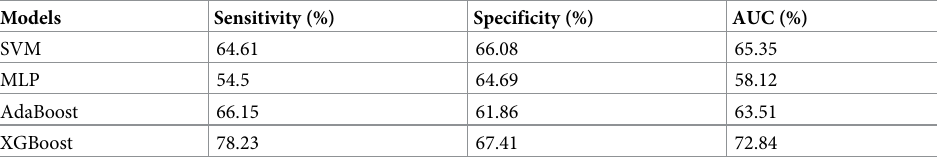
Table 2. Classification performance of four machine learning algorithms on the test